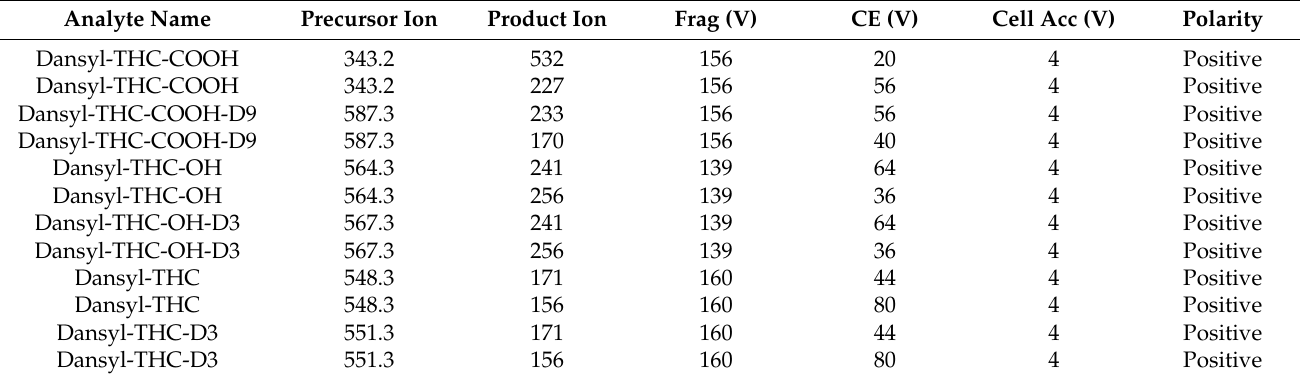
Table 8. LC-MS/MS ion transitions monitored for danysl derivatives of cannabinoids in human